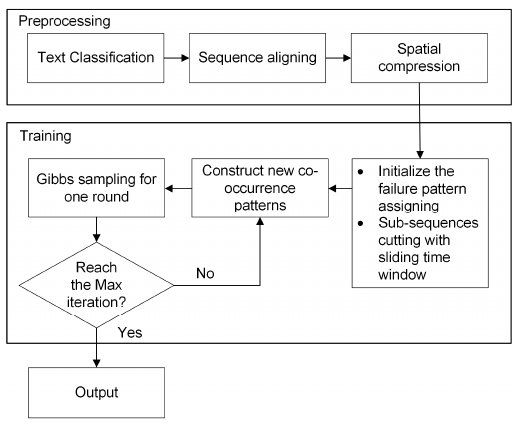
Figure 8. Log analysis framework by the temporal Latent Dirichlet Allocation (TLDA).